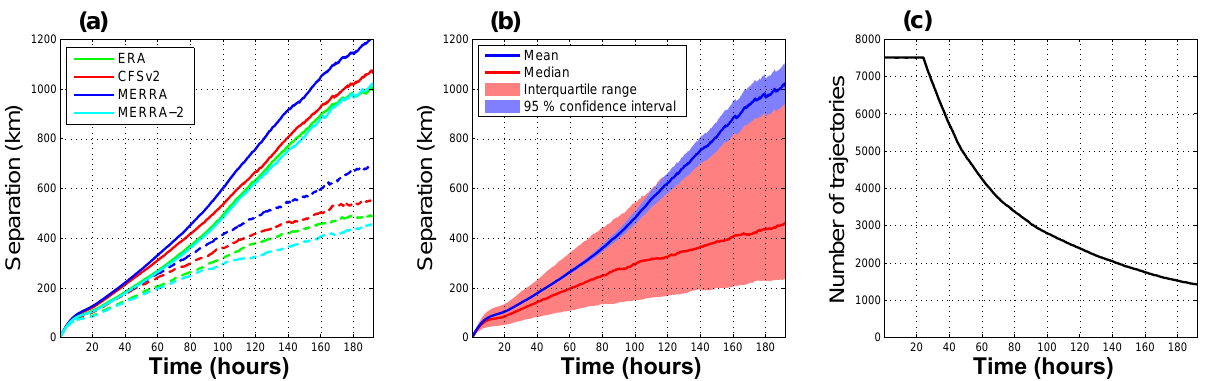
Figure 5. Trajectory separations as a function of time. (a) shows a comparison of the trajectory quality of each of the reanalyses with solid lines representing the mean and dashed lines the median separations. (b) provides a more detailed plot of the MERRA-2 trajectories, including confidence intervals and inter-quartile ranges. More detailed plots for the other reanalyses show very similar characteristics to those observed in (b) . (c) provides information on the number of trajectories included at each hour mark, decreasing due trajectories running over altitude changes.